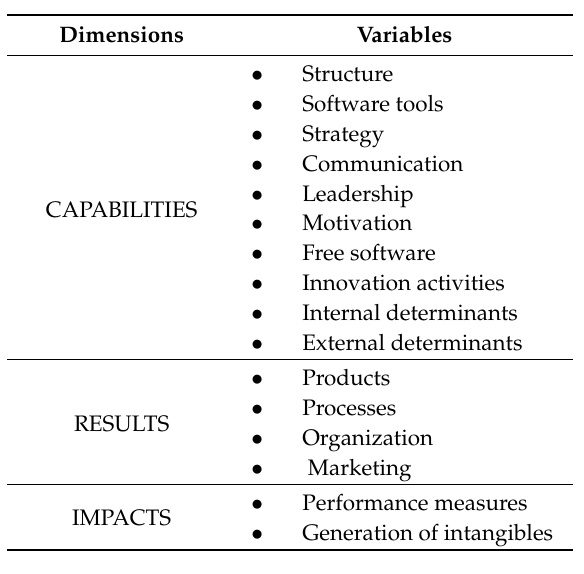
Table 1. Innovation measurement model: dimensions and